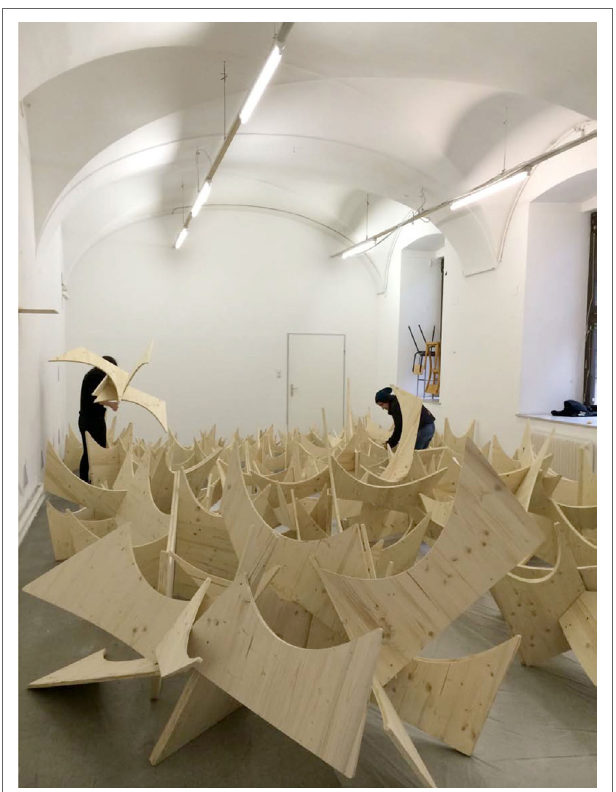
FIgURe 7 | The pre-assembled node modules act as lost formwork.